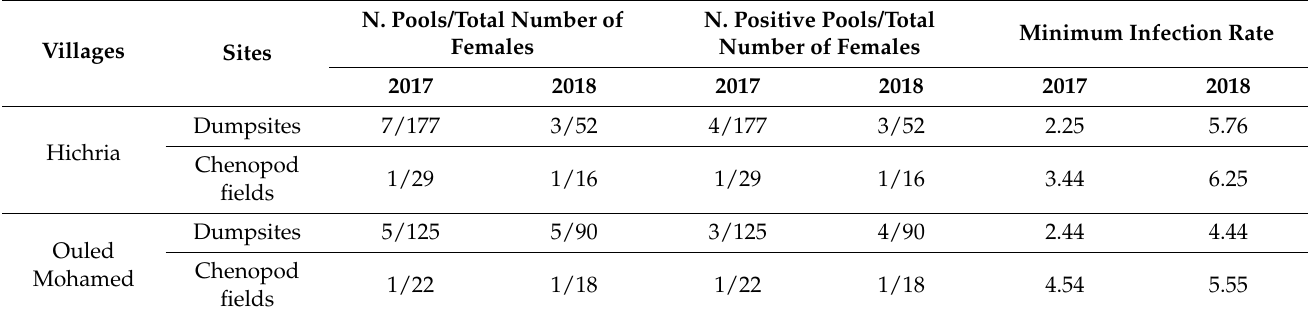
Table 2. Minimum infection rates of Phlebotomus papatasi with Leishmania major in Hichria and in Ouled Mohamed.